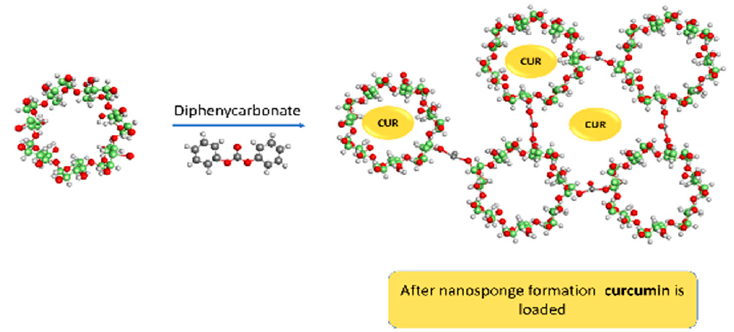
Figure 1. Schematic representation of the curcumin-loaded DPC cross-linked nanosponges.